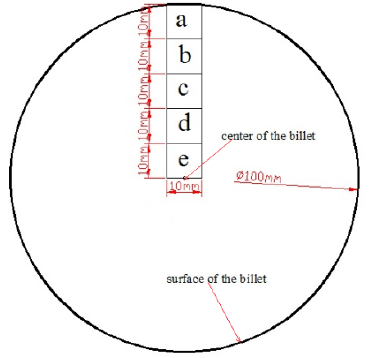
Figure 1. Schematic diagram of sampling for casting microstructure analysis.